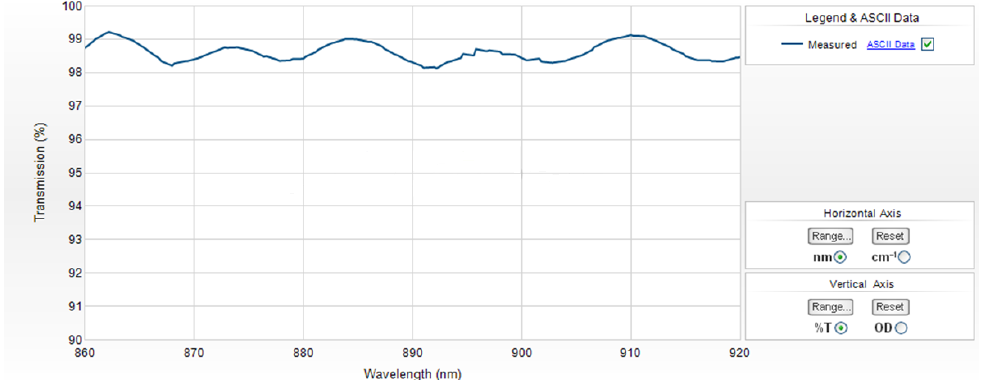
Figure 4. 785 nm EdgeBasic™ best-value long-pass edge filter spectrum. Reprinted with permission from Ref. [34]. 2022, Semrock Optical Filters. © IDEX Health & Science, Semrock Optical Filters www.semrock.com (accessed on 11 August 2022).